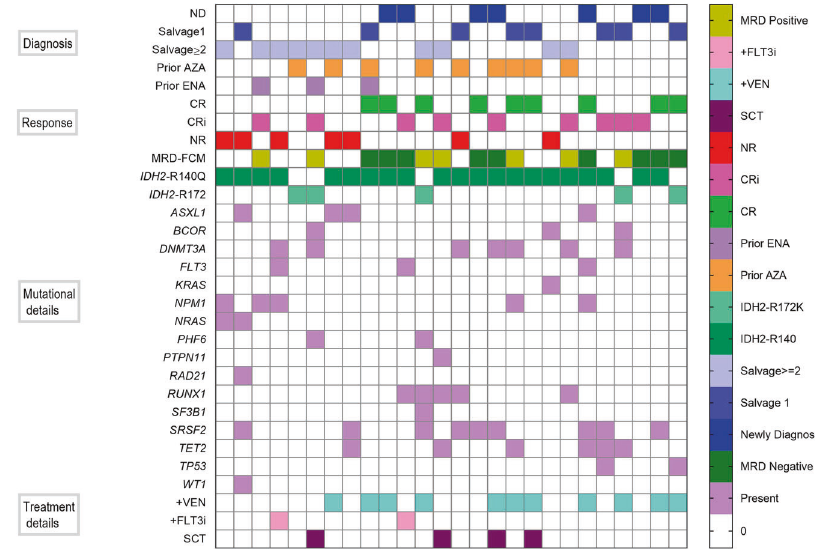
Fig. 4 Landscape of entire cohort with genomics and outcomes. Mutational landscape of the whole cohort.